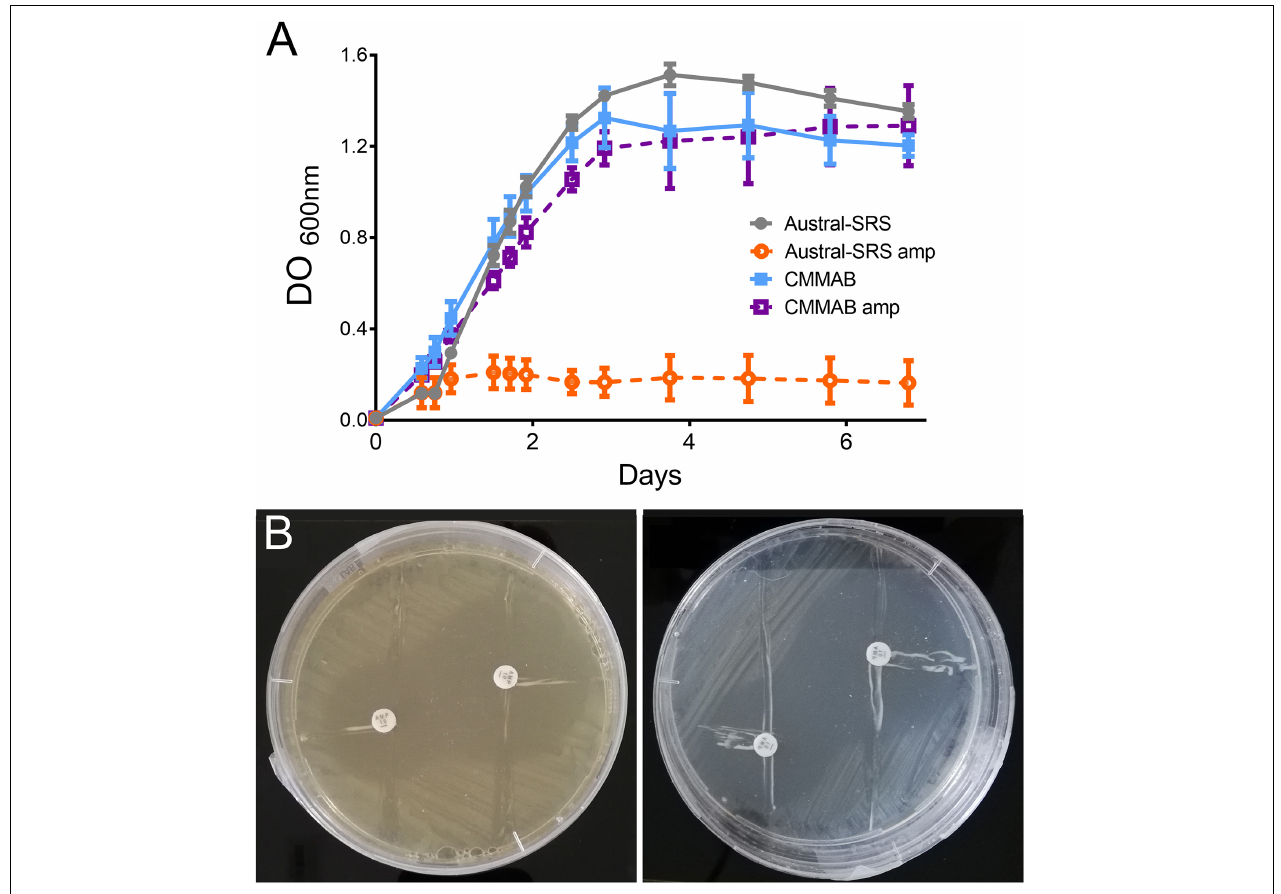
FIGURE 4 | P. salmonis LF-89 response to ampicillin. (A) P. salmonis growth curves in nutrient (Austral-SRS) and optimized defined (CMMAB) culture media with and without ampicillin (amp). (B) P. salmonis clover-leaf test for ampicillin. E. coli DH5 α was used as the indicator strain. E. coli and P. salmonis were grown in Austral-SRS (left) and CMMAB (right) agar plates with disks containing 100 mg and 500 mg of amp (small and large inhibition zone,